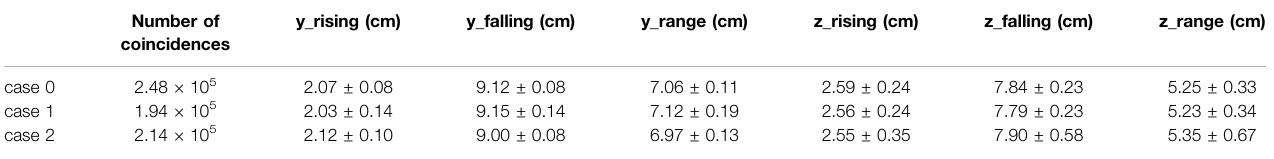
TABLE1| Numberofcoincidencesandrangeparametersoftheactivitypro fi leinthe y and z directionforasimulated5 × 7 × 5 cm 3 homogeneousactivity.Thereconstructed range matches the expected value within the error, for both projections and for all the con fi